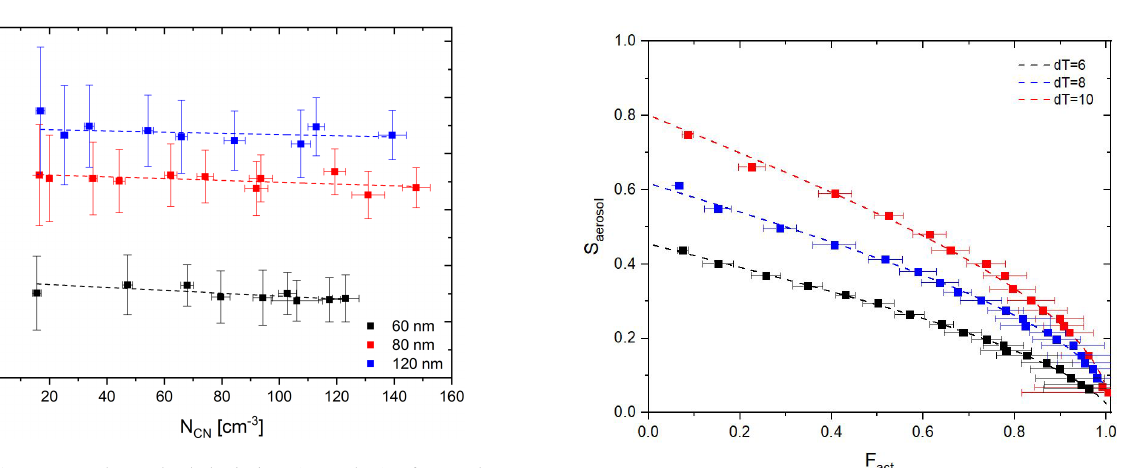
Figure 6. Average and standard deviation (error bar) of F act de- pending on the number concentration N CN for 60 (black), 80 (red), and 120nm (blue) of ammonium sulfate particles under the d T = 7 . 7K (0.6% S) condition. Dashed lines indicate linear regression lines.